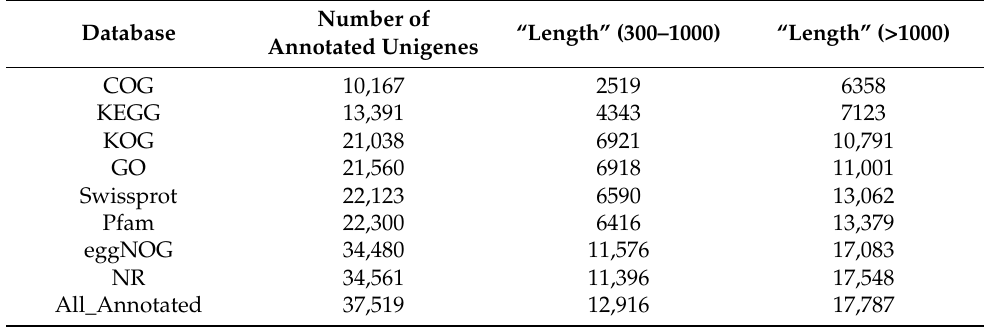
Table 2. The general overview of the number of annotated unigenes in databases including